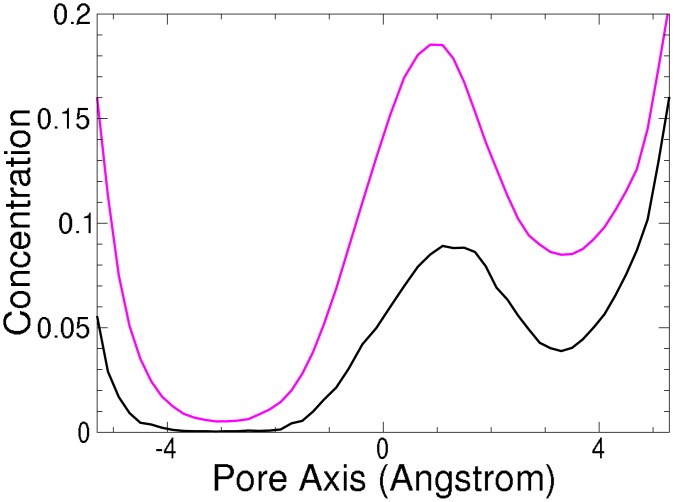
Simulated cation profile (as moving average over 2Å) in the Na+ (NavAb) ion channel SF.[Na+·X] pink and [K+·X] black. Concentration minimum region used to calculate selectivity [−4.0 : −2.0].